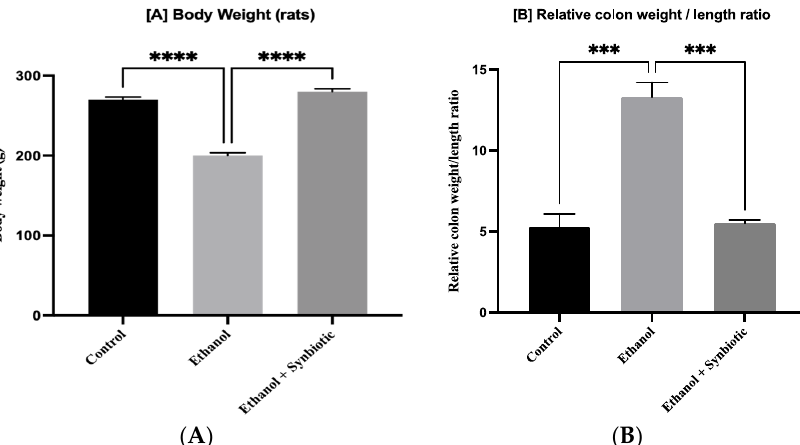
Figure 4. Synbiotic (AGE + L. rhamnosus ) affects gut dysbiosis caused by ethanol dosage. ( A ) Body weight and ( B ) relative weight and length proportion of the colon are represented above. The statistical analysis was calculated as mentioned in Section 2.10. Mean − /+ SD was determined for N = 6 replicates. For statistical analysis, GraphPad Prism 7 and one-way ANOVA in conjunction with the Tukey post hoc test were calculated. When associated with the ethanol group, significance ( p -value) is defined as *** p < 0.001, **** p < 0.0001.